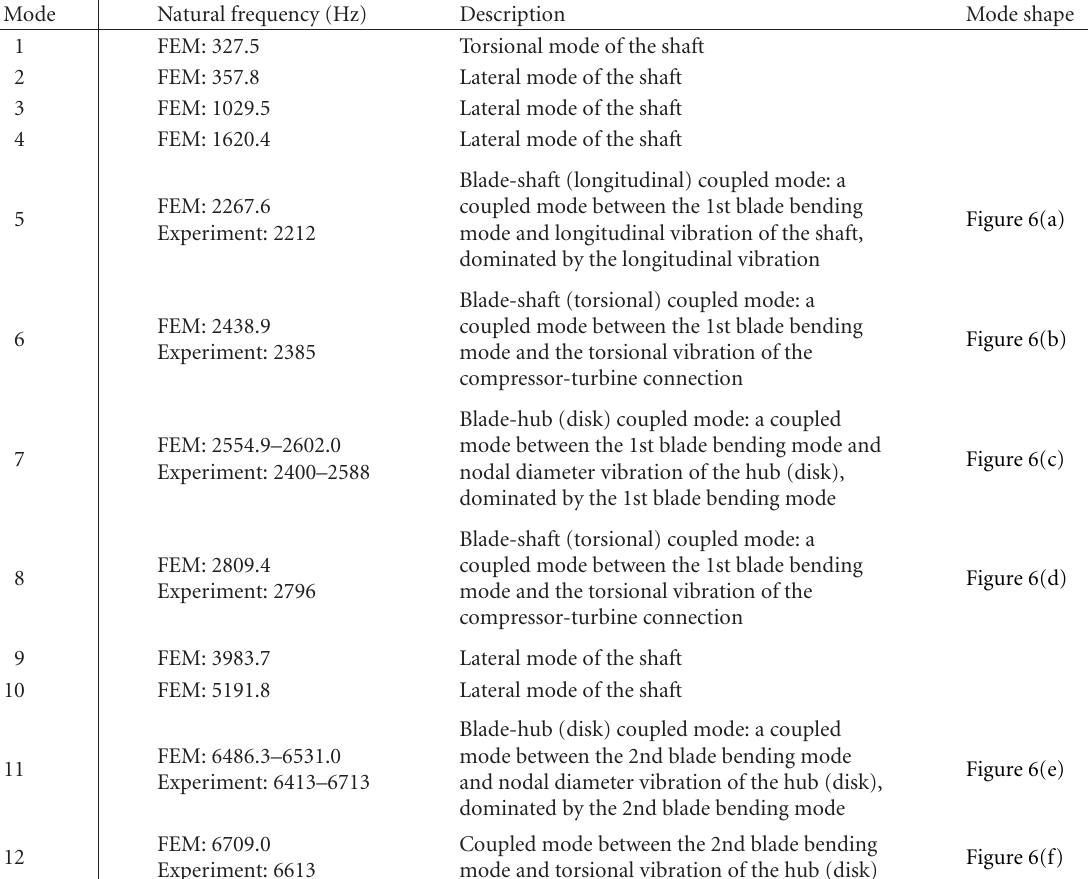
Table 1: Natural frequencies and description of all the elastic modes in the frequency range of 0–7000 Hz, at room temperature and in a nonrotating state ( N =